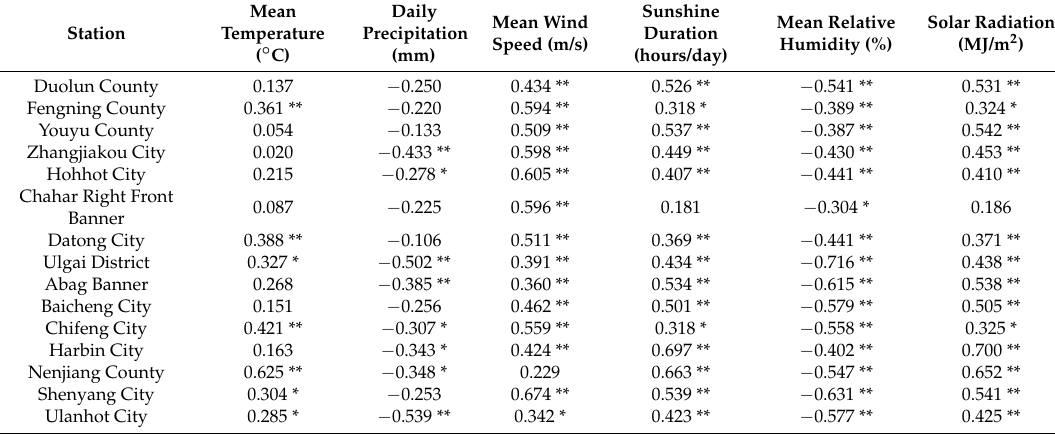
Table 4. Correlation of oat water requirement with climatic factors in North and Northeast China from 1960 to 2015.